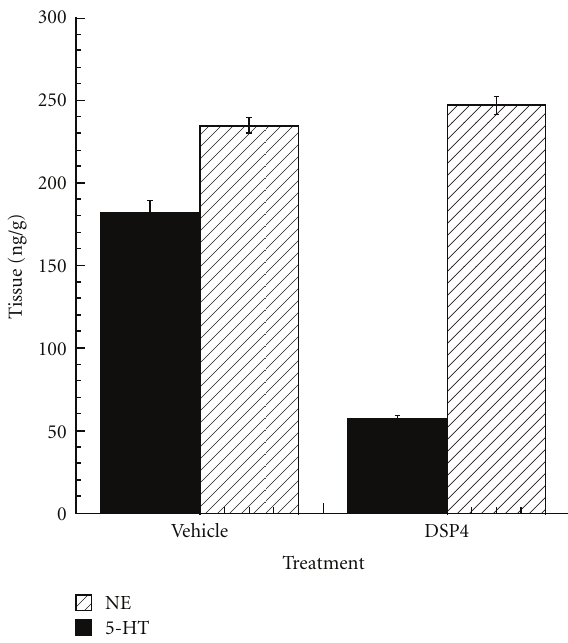
Figure 1: E ff ects of treatment with DSP4 on monoamine neuro- transmitter levels. DSP4 (50mg/kg in PBS, N = 5) or PBS (vehicle, N = 5) was administered intraperitoneally to C57BL/6SJL mice on days 1 and 7. Mice were sacrificed 7 days following the second injection (day 14). Brain was harvested and frontal cortex dissected for analysis of monoamine concentrations, demonstrating a 68% reduction of NE levels but no e ff ect on